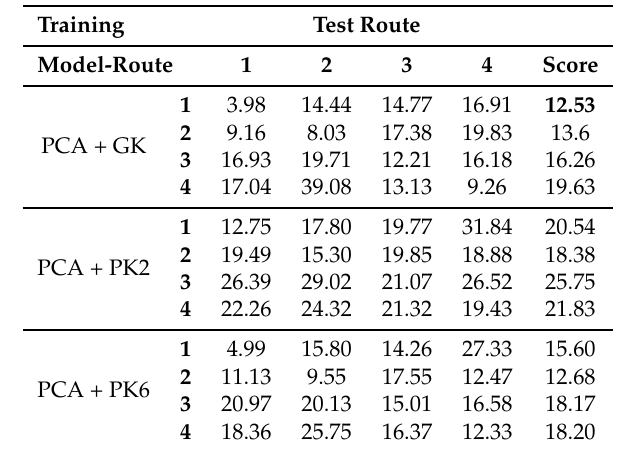
Table 4. RMSEs of SVR PCA + GK, PCA + PK2 and PCA + PK6 models trained using four routes tested against the other routes.